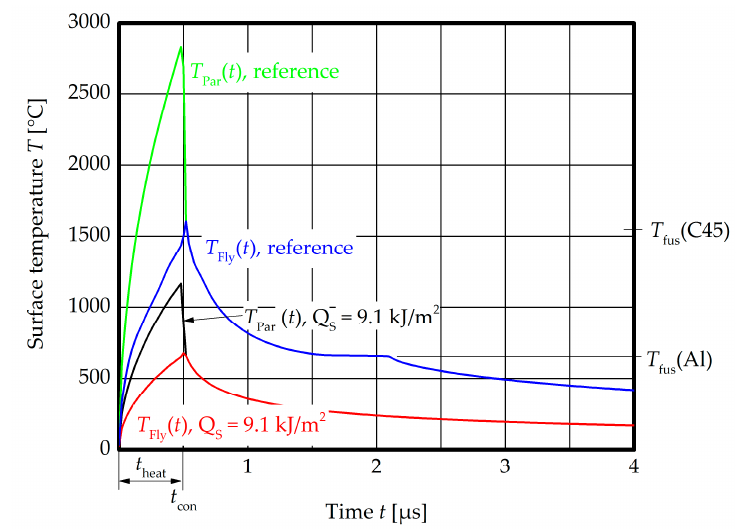
Figure 18. Comparison of T Fly ( t ) and T Par ( t ) for the reference setup and the setup with 9100 J/m 2 heat quantity at each surface.